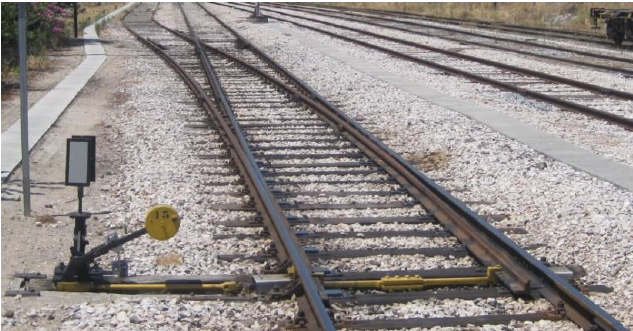
Figure 1. A turnout with its switch in the “direct track” position.